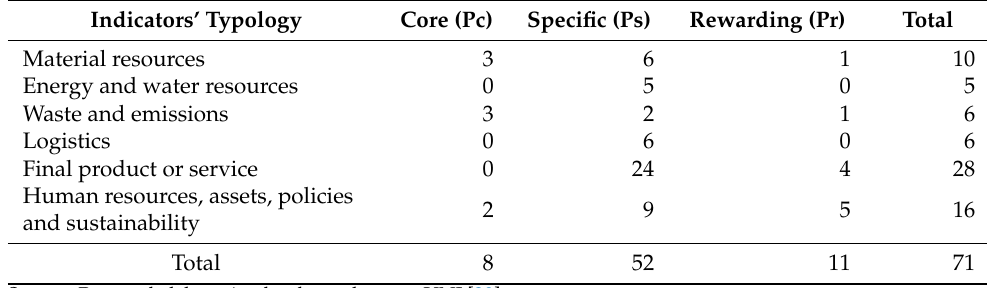
Table 1. Indicators